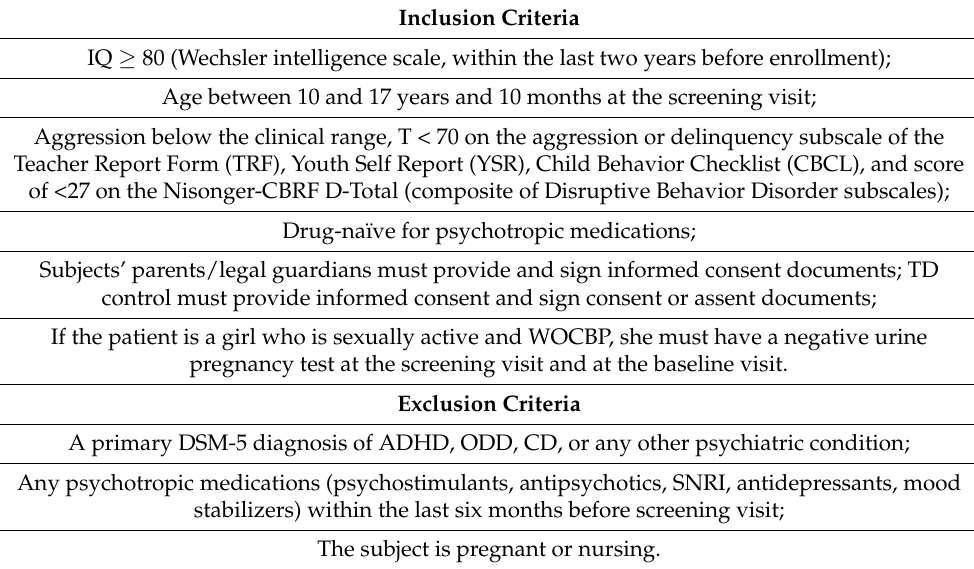
Table 3. Inclusion and exclusion criteria for the TDC group.